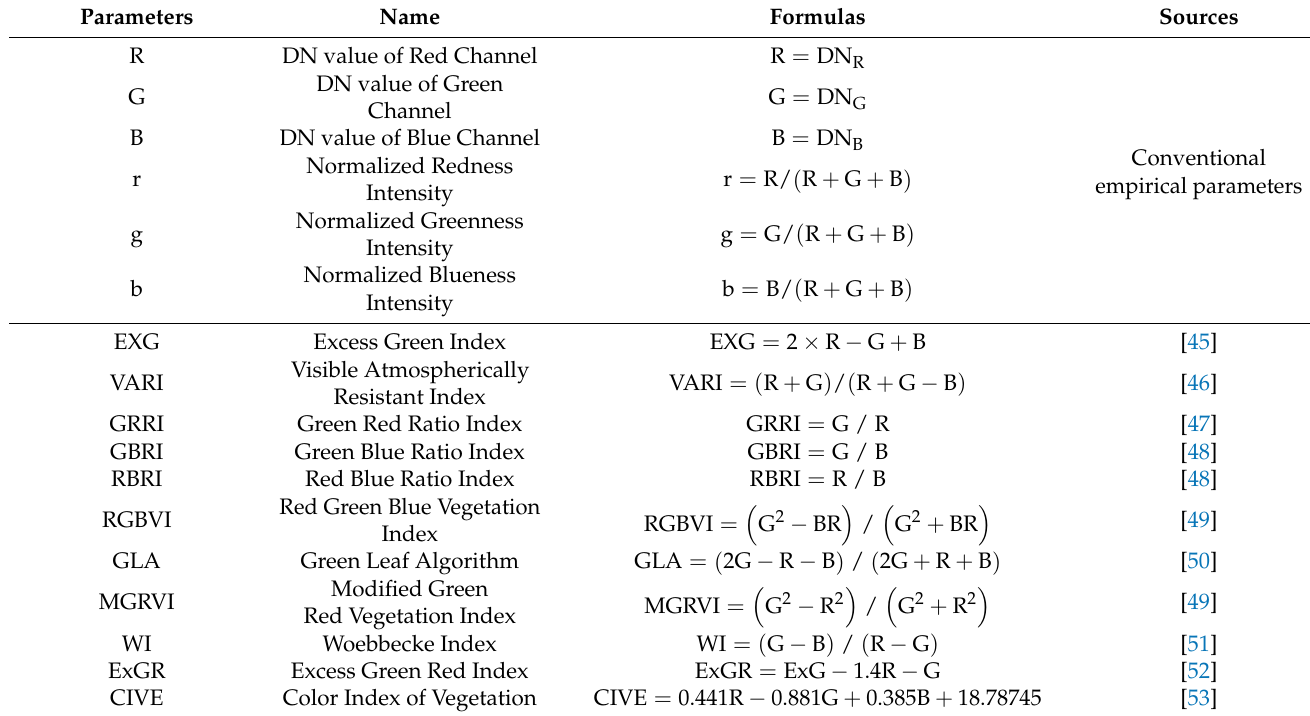
Table 2. Spectral parameters related to LAI of UAV RGB images.